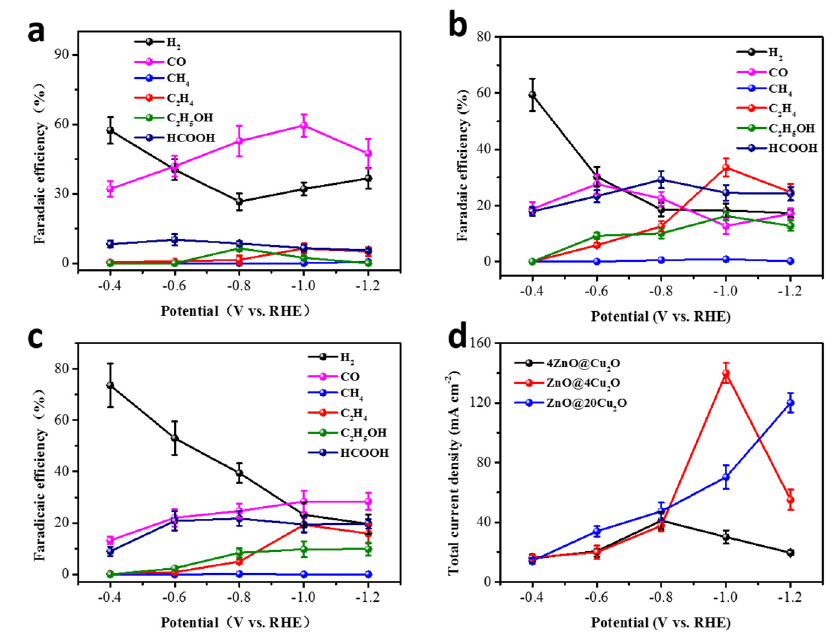
Figure 6. Faradaic efficiency of products on xZnO@uCu 2 O catalysts ( a ) 4ZnO@Cu 2 O, ( b ) ZnO@4Cu 2 O, and ( c ) ZnO@20Cu 2 O. ( d ) The total current density of products on xZnO@yCu 2 O catalysts.